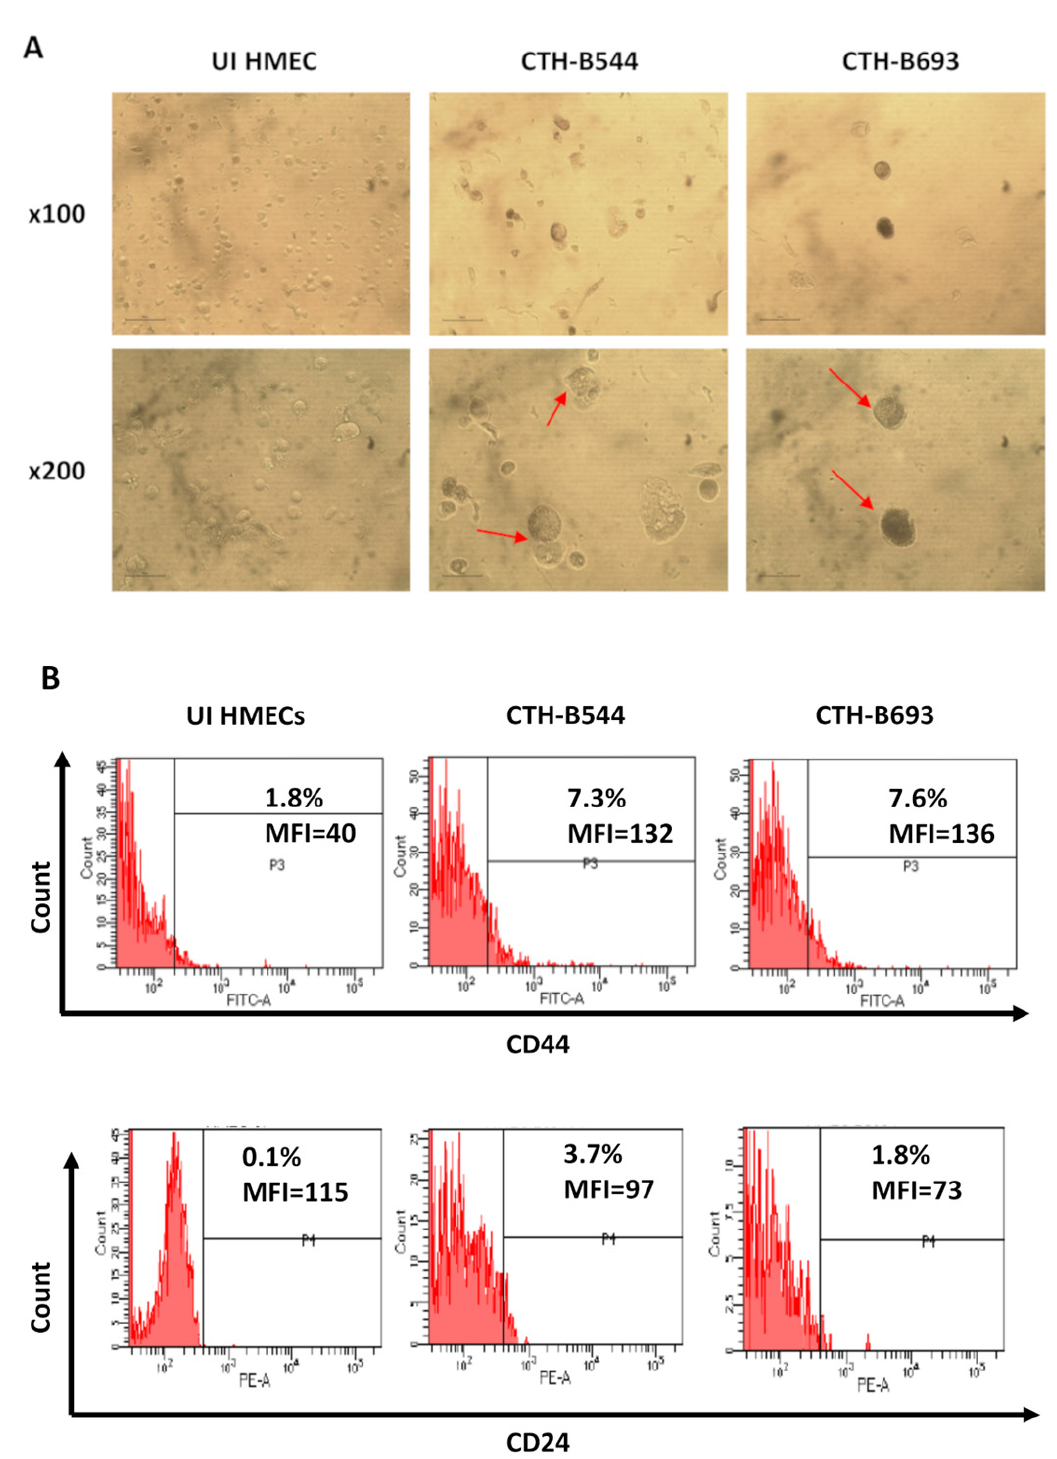
Figure 4. Tumorspheres formation and the expression of stemness markers in CTH cells. ( A ) Tu- morspheres were observed under an inverted light microscope in CTH-B544 and CTH-B693 cells. Magnification × 100 and × 200, scale bare 100 µ m. Uninfected HMECs were used as a negative control. ( B ) FACS staining of CD44 and CD24 was performed in CTH cells. Results are representative of three independent experiments.